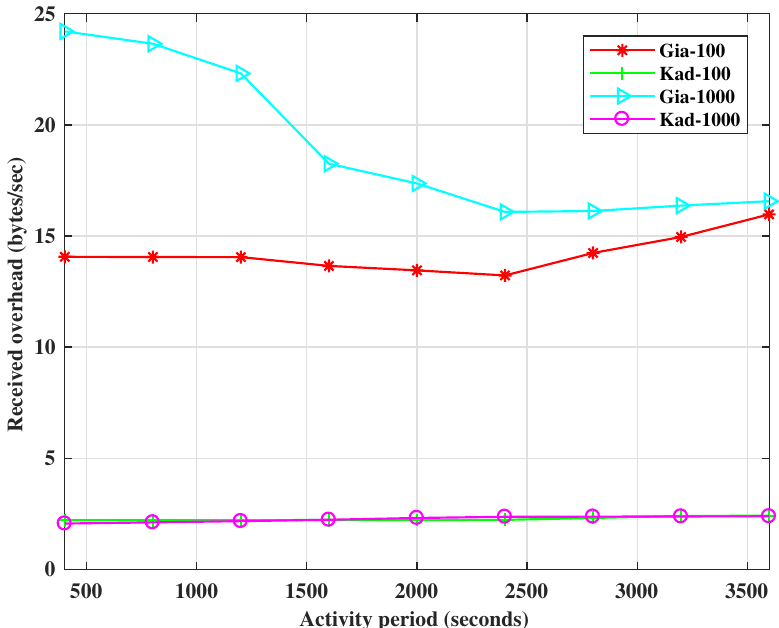
Figure 9. Evaluation of the amount of bandwidth overhead received by each peer when using Kademlia compared to when using Gia P2P